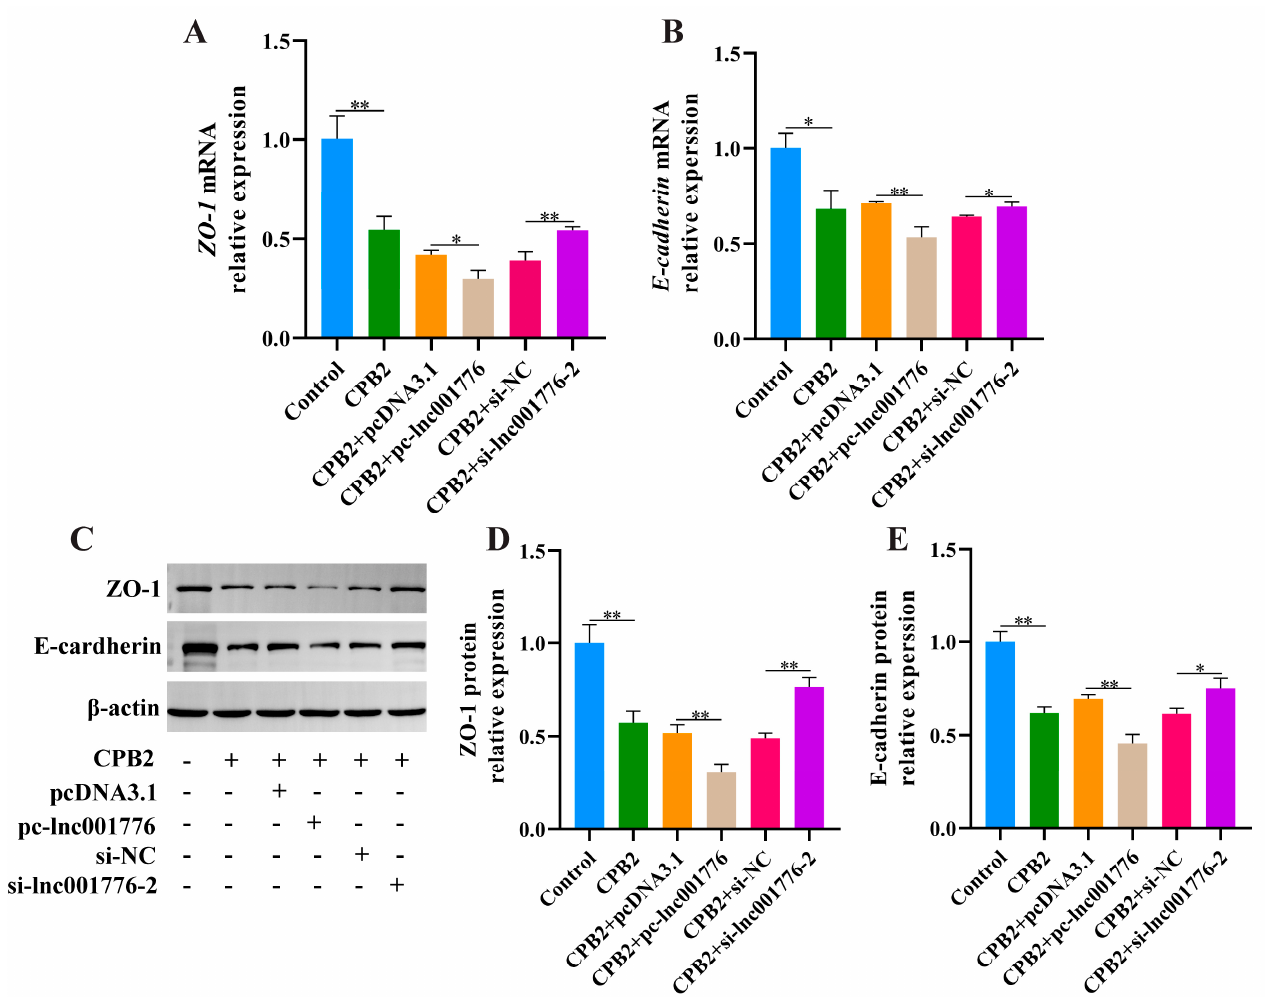
Figure 4. lnc001776 knockdown ameliorated the disruption of IPEC − J2 cell barrier integrity by CPB2 toxin. ( A , B ) ZO − 1 and E-cadherin mRNA expression through RT-qPCR. ( C – E ) ZO − 1 and E − cadherin protein expression via Western blot. * p < 0.05, ** p < 0.01.